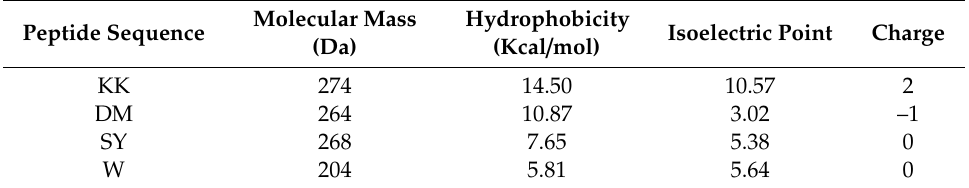
Table 5. Sequences and Properties of Mung Bean Albumin Peptides Derived from Thermolysin Enzymatic Hydrolysis. Peptide